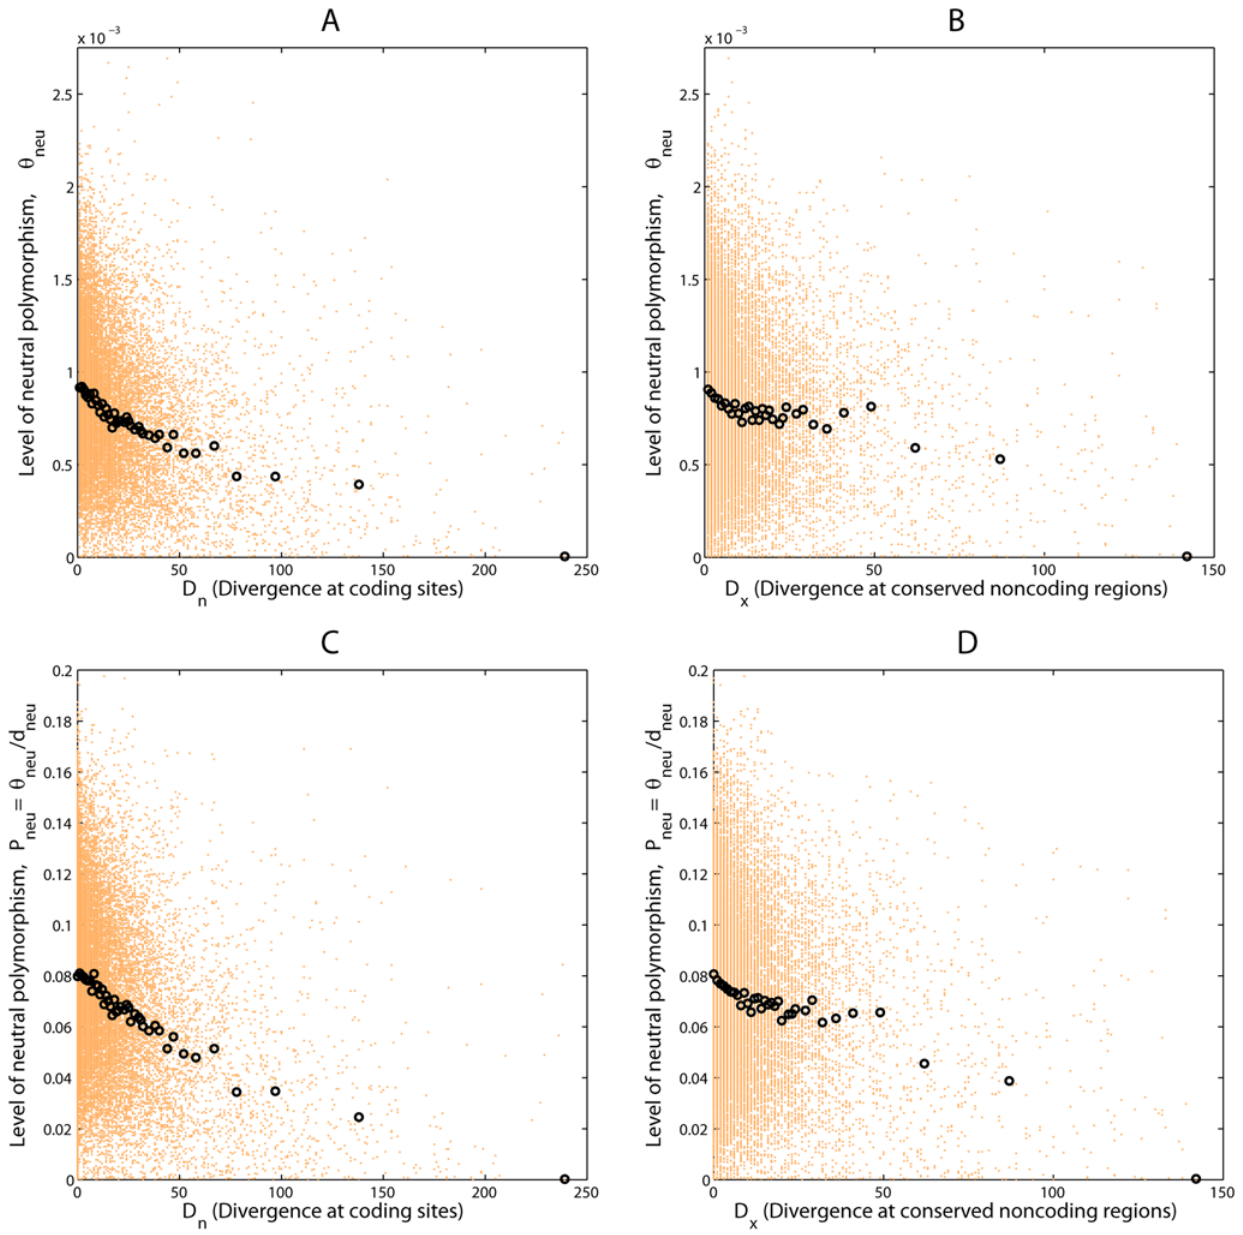
Figure 3. Relationships among the levels of functional divergence and neutral polymorphism. Scatter plots display values of two variables in orange dots for (A) the divergence at coding sites ( D n ) and the level of neutral polymorphism ( h neu ), (B) the divergence at conserved noncoding region ( D x ) and the level of neutral polymorphism ( h neu ), (C) the divergence at coding sites ( D n ) and the level of normalized neutral polymorphism ( P neu = h neu / d neu ), and (D) the divergence at conserved noncoding region ( D x ) and the level of normalized neutral polymorphism ( P neu = h neu / d neu ). Black circles are average values for orange dots pooled in 100 bins each containing 1% of the data points.